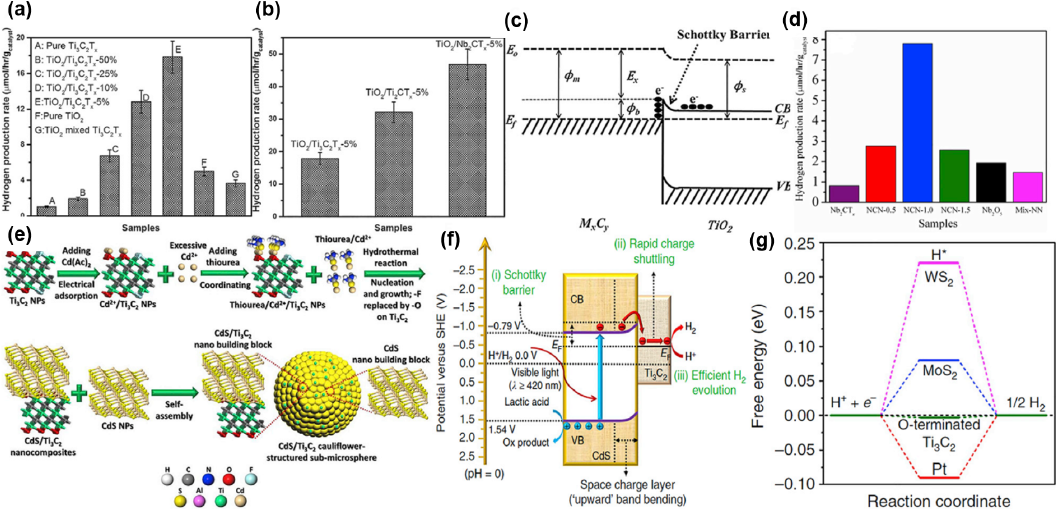
Figure 14. ( a ) The rate of hydrogen revolution reaction for TiO 2 /Ti 3 C 2 T x and the corresponding control samples, ( b ) HER photocatalytic activity of TiO 2 loaded with different MXene as co-catalysts (Ti 3 C 2 T x , Ti 2 CT x , and Nb 2 CT x ), ( c ) the formation of a Schottky barrier at the MXene/TiO 2 heterointerface. Reproduced with permission from reference [187]. Copyright 2018, Wiley-VCH. ( d )